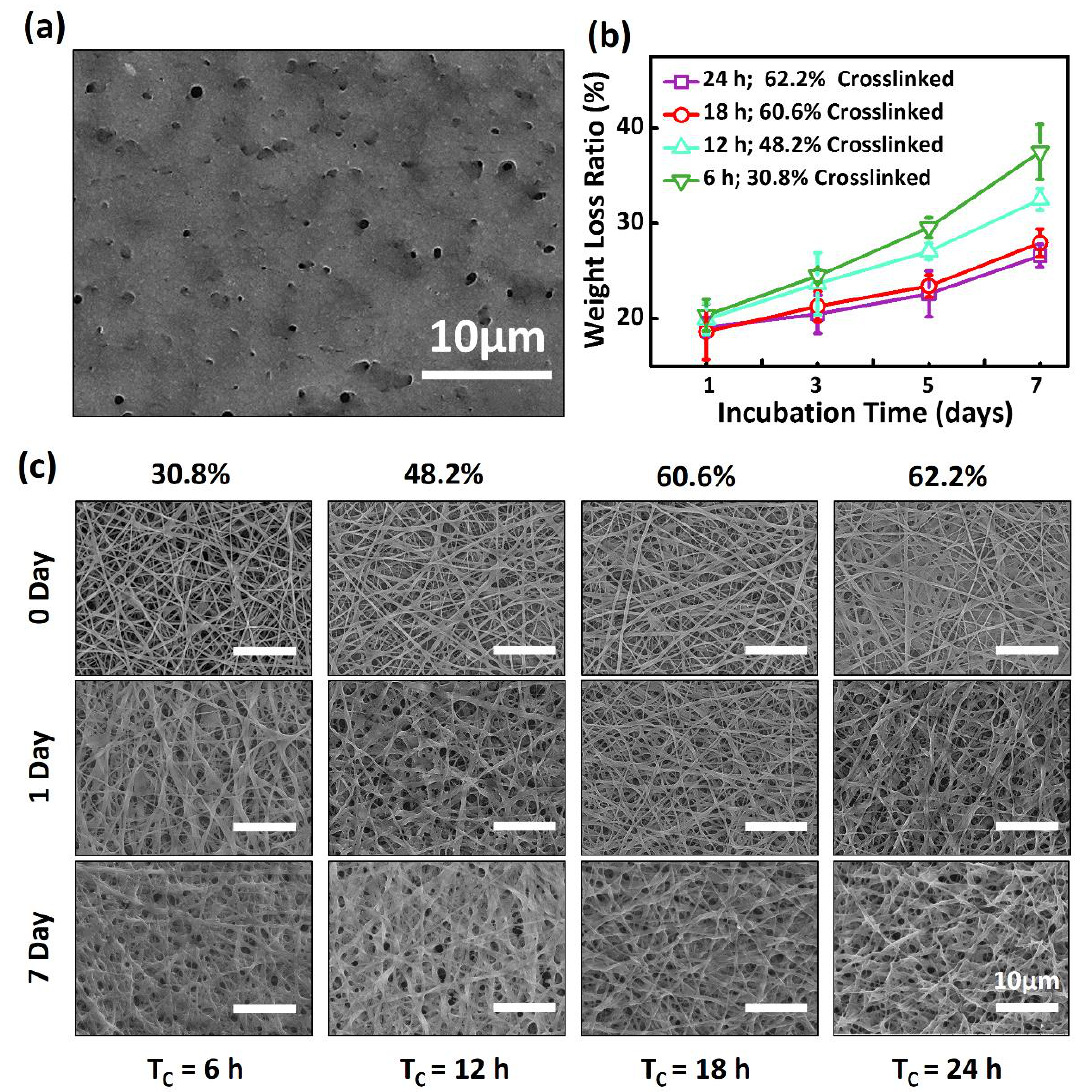
Figure 3. ( a ) Morphology of non-crosslinked nanofibers after being immersed in Phosphate-buffered saline (PBS) for 1 h; ( b ) Degradation of crosslinked nanofibrous membranes with varied degrees of crosslinking in PBS at 37 °C for up to 7 days; ( c ) Surface SEM micrographs of the membranes possessed varied degrees of crosslinking after incubation in PBS for 0 day, 1 day and 7 days. Scale bar is 10 μm for all images. T C is the time of crosslinking.